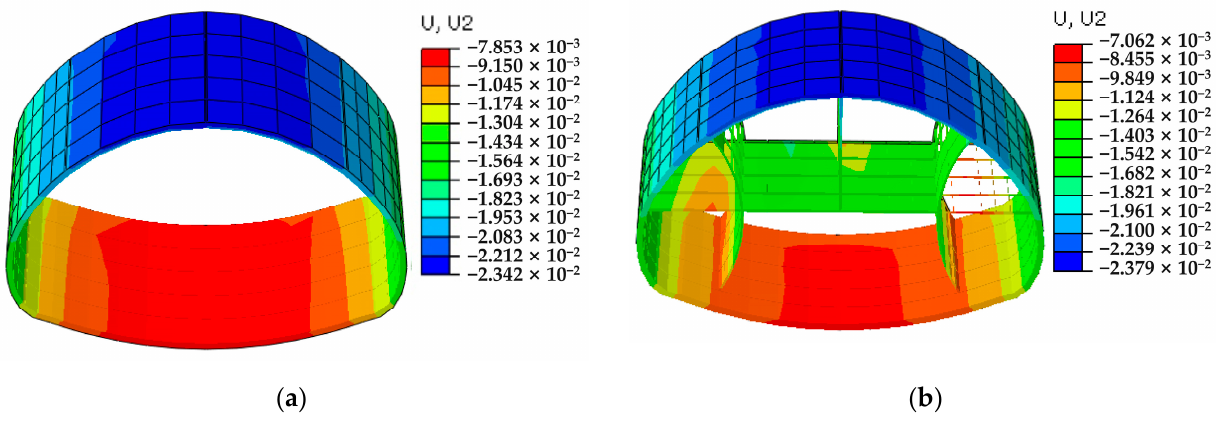
Figure 20. The vertical displacement of the lining after the temporary support was removed (unit: m): ( a ) Condition 1 and ( b ) Condition 2.